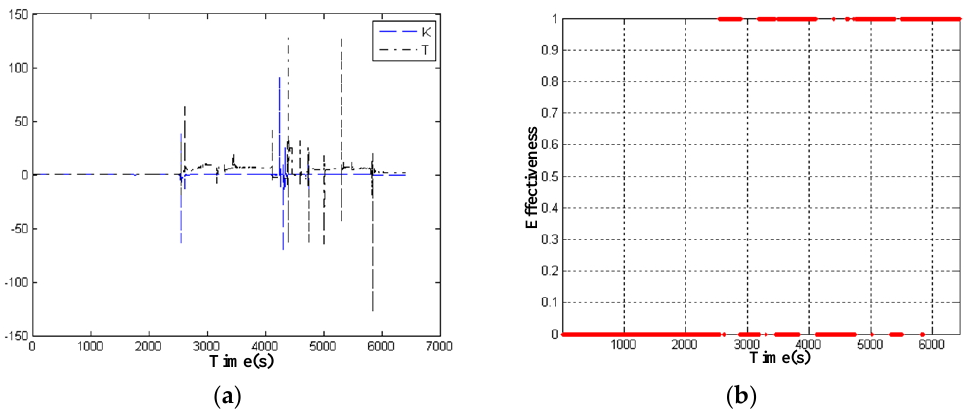
Figure 16. Online Identification. ( a ) parameter identification K , τ ; ( b ) Validity judgment (1 means valid, 0 means inva- lid).